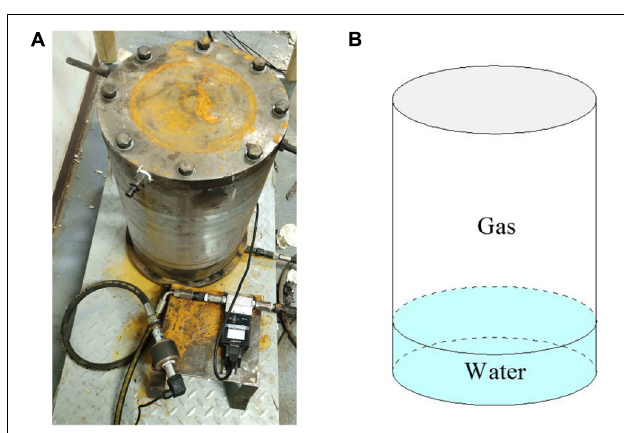
FIGURE 2 | Photograph (A) and schematic (B) of the stable hydraulic pressure supply device.